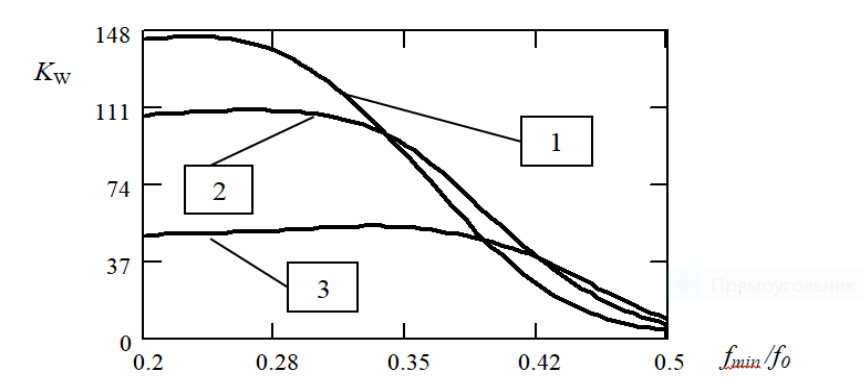
Fig. 2. The dependence of K W on the high-frequency